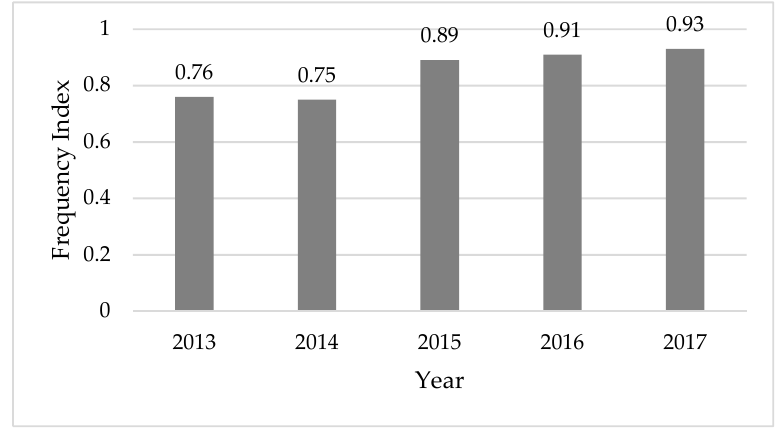
Figure 9. Frequency index of non-fatal accidents in Romania during 2013–2017 [2].